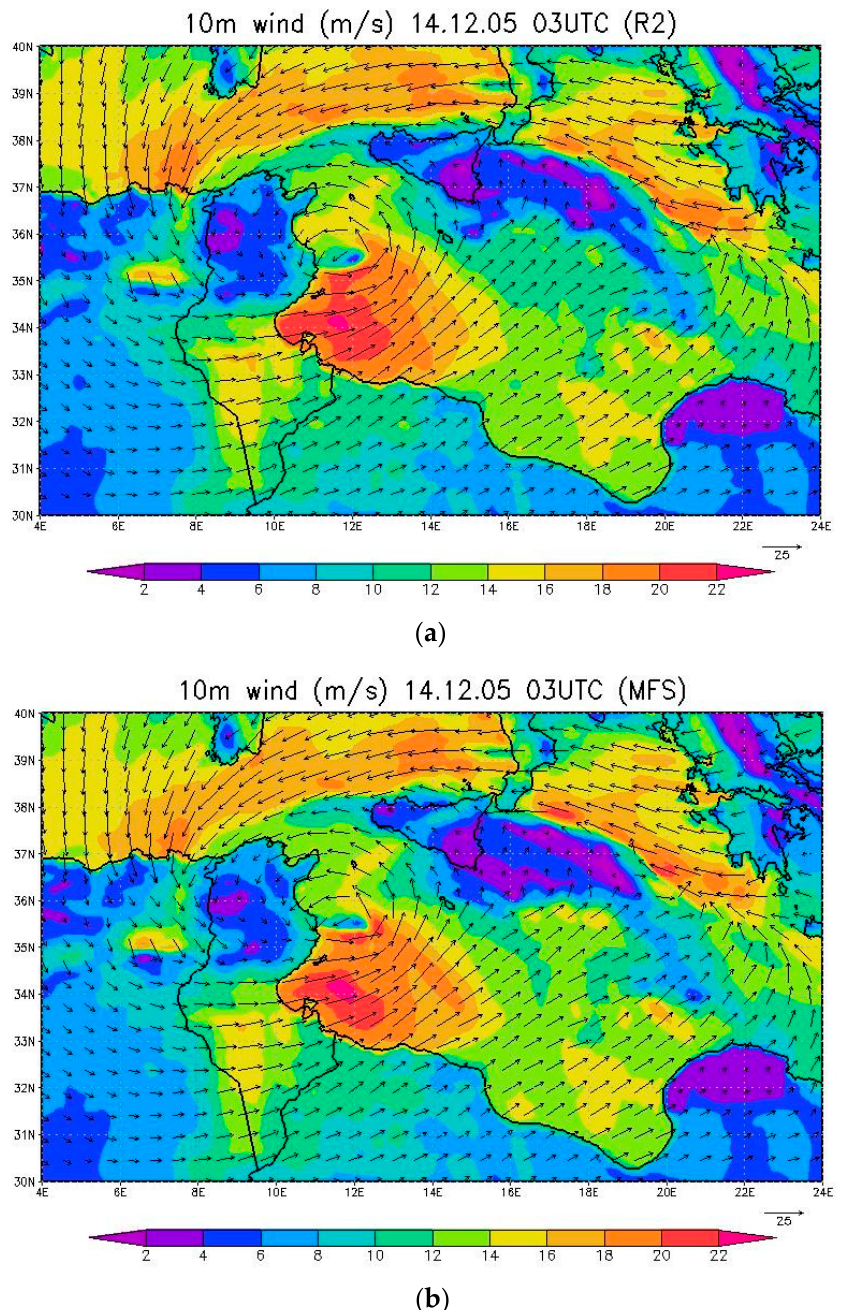
Figure 15. Maps were prepared with GrADS which does not allow control over axis labels. To replot would require extensive manual editing. 10 m winds (ms - ) on 14 December 2005 03:00 UTC from ( a ) the R2 run and ( b ) the MFS run.